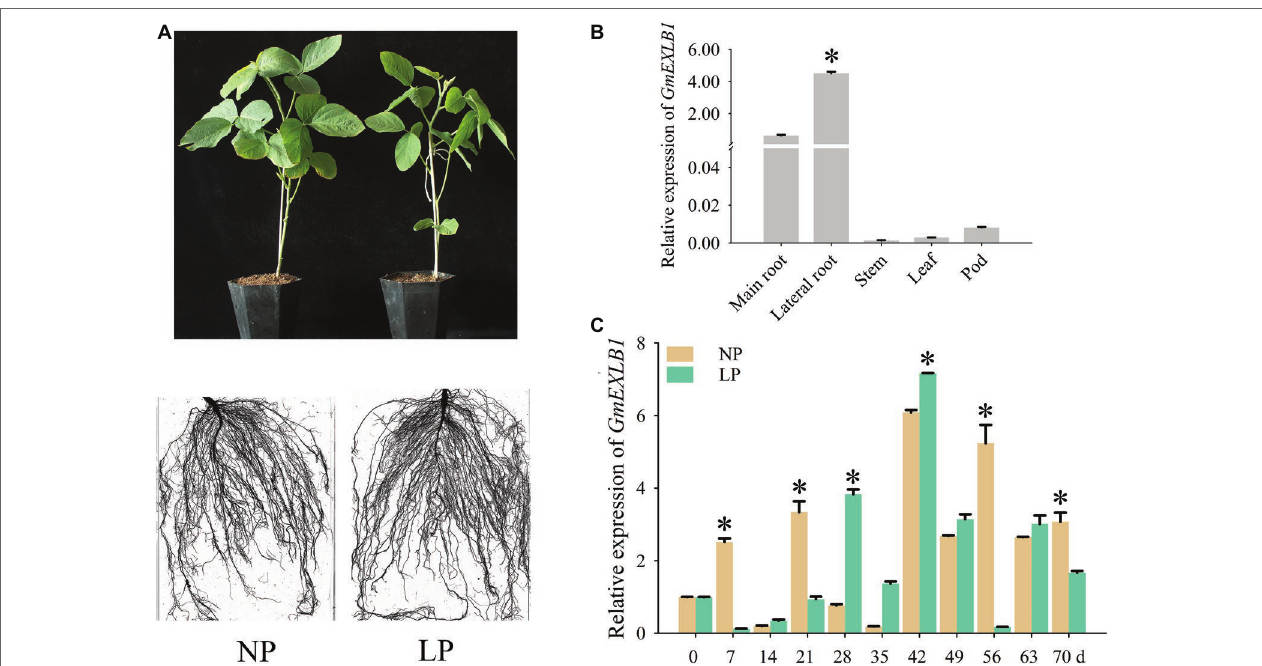
FIGURE 4 | Analysis of GmEXLB1 expression patterns in soybean. (A) Phenotype of zhonghuang15 (ZH15) under normal phosphorus (NP) and low phosphorus (LP) conditions. (B) Expression analysis of GmEXLB1 in different ZH15 tissues under LP conditions. The relative expression was calculated using the 2 −ΔΔCT method, and the data are the mean ± SE ( n = 3). Error bars represent the SE. Asterisks indicate significant differences ( p < 0.05). (C) Expression of GmEXLB1 in lateral roots in ZH15. Seven-day-old seedlings were treated with NP and LP (0 day seedlings were used as a control). Lateral roots were sampled after 7, 14, 21, 28, 35, 42, 49, 56, 63, and 70 days and were used for temporal expression analysis. The relative expression was calculated using the 2 −ΔΔCT method, and the data are the mean ± SE ( n = 3). Error bars represent the SE. Asterisks indicate significant differences ( p <